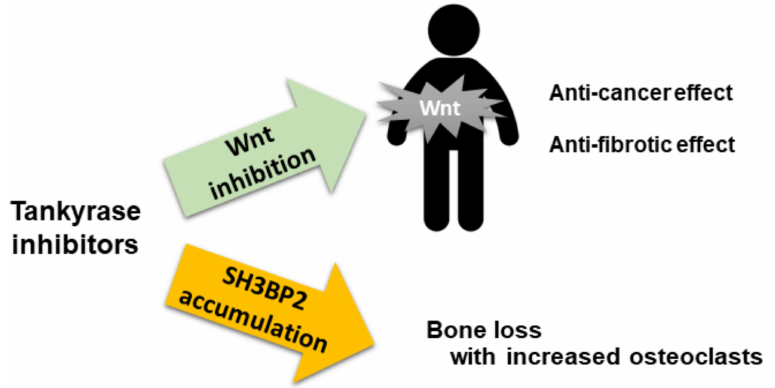
Figure 6. Possible adverse effect of tankyrase inhibitors on bone. Tankyrase inhibitors exert anti-cancer and anti-fibrotic effects via Wnt inhibition. Simultaneously, these inhibitors could induce systemic bone loss with increased number of osteoclasts via SH3BP2